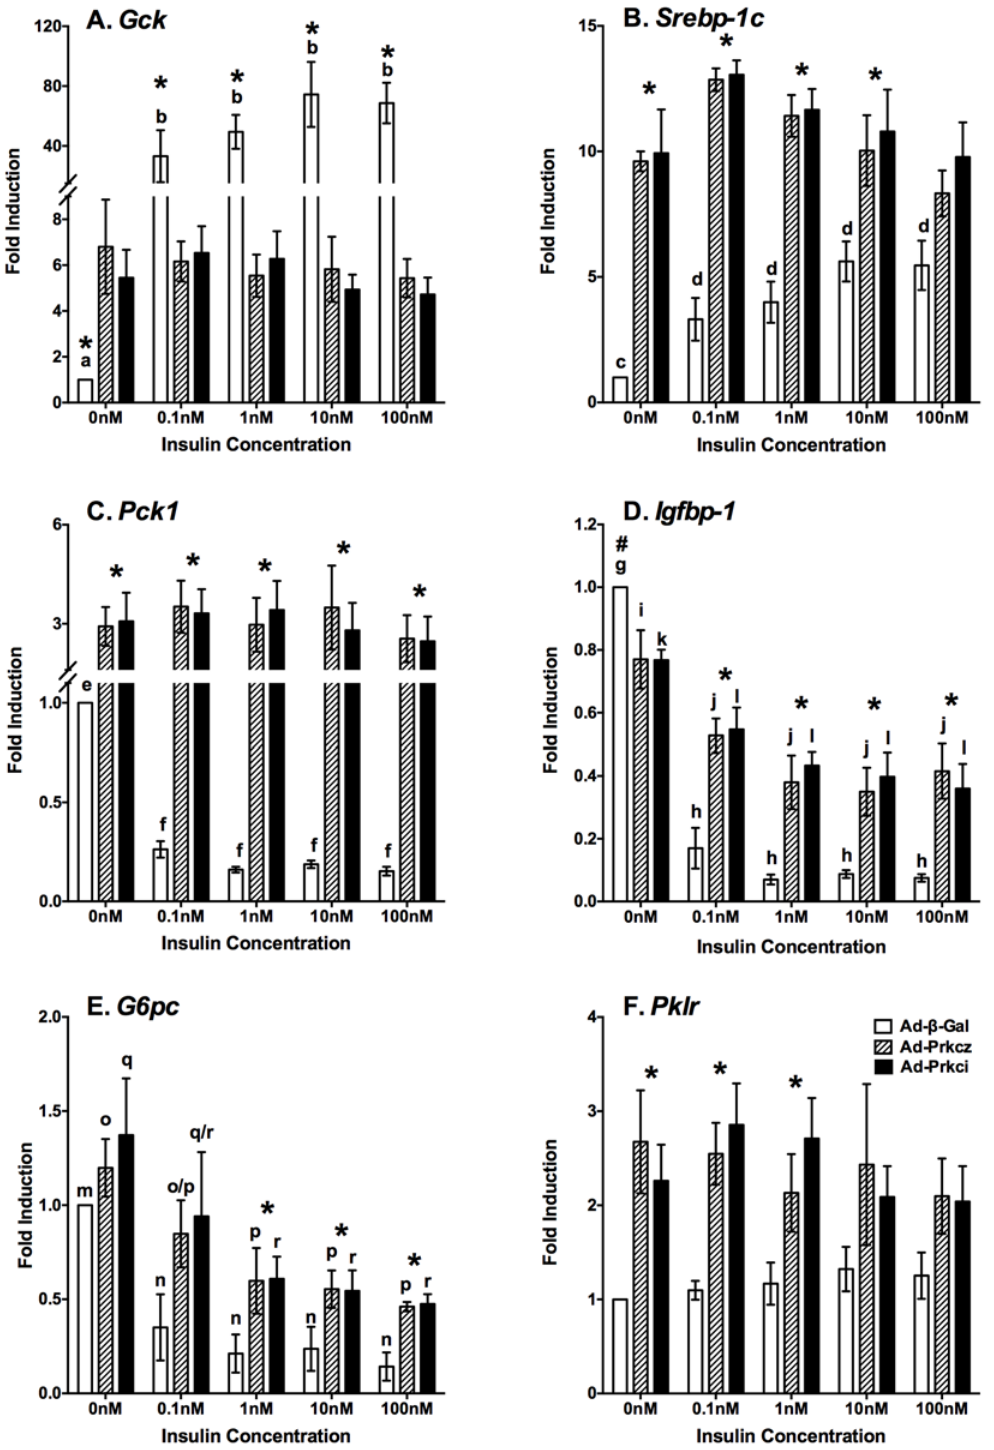
Fig 6. Overexpression of PKC ζ and PKC ι / λ impaired the insulin-regulated gene expression in ZL primary rat hepatocytes. Primary hepatocytes of ZL rats fed chow for 8 weeks were isolated and seeded onto dishes as described in the Materials and Methods. Purified Ad- β -gal, Ad-Prkcz and Ad-Prkci were added in medium A during the overnight pretreatment period to allow the overexpression of β -GAL, PKC ζ and PKC ι / λ , respectively. The primary hepatocytes were then incubated in fresh medium A with increasing concentrations of insulin (0nM to 100nM) for 6 hours. Total RNA was extracted, and subjected to real- time PCR analysis. The transcript level of each indicated gene in primary hepatocytes transfected with Ad- β -gal in the absence of insulin treatment